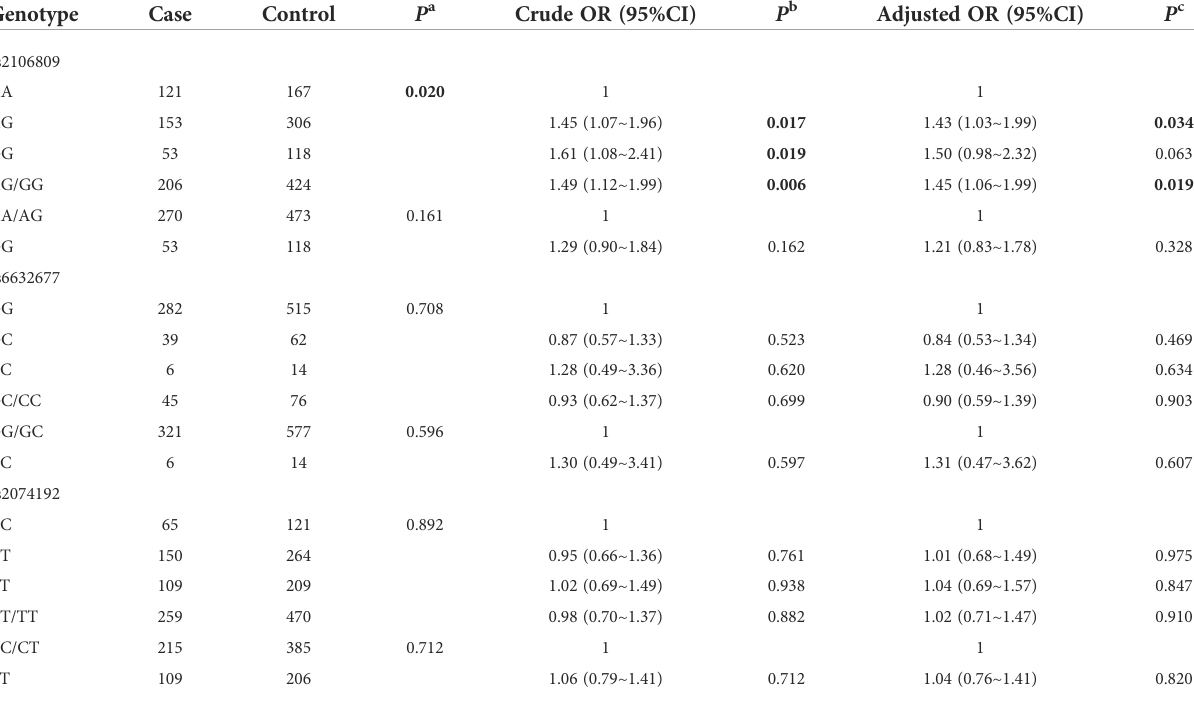
TABLE 3 Association between genotypes of selected SNPs and PE risk.